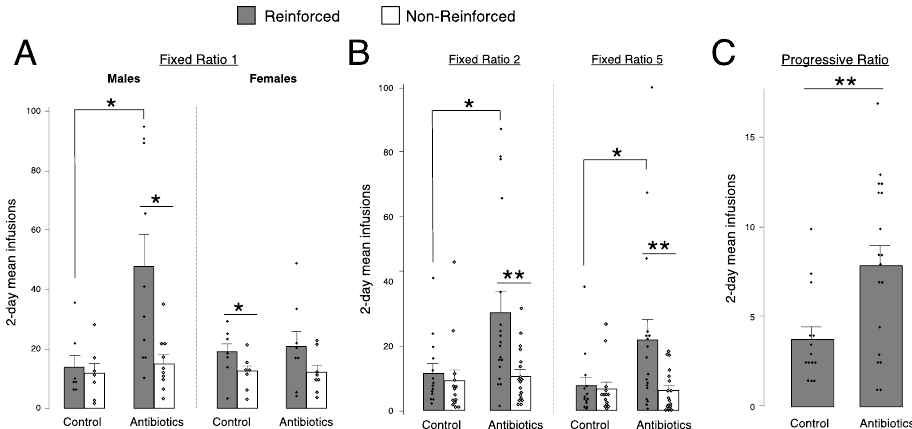
Figure 4. Fentanyl intravenous self-administration in controls and antibiotic-treated animals. All animals self-administered a fentanyl dose of 1.25 µ g/kg/infusion. ( A ) Mean number of infusions across days 4–5 at fixed ratio (FR) 1 in males and females. Infusions were administered via nose pokes and are reported as reinforced (filled bars and circles) and non-reinforced (empty bars and circles) responses. Error bars represent S.E.M., * p < 0.05, n = 7–10/group. ( B ) Mean number of infusions across 2 days at FR2 and 2 days at FR5, collapsed by sex, for reinforced (filled bars and circles) and non-reinforced (empty bars and circles) nose poke responses. Error bars represent S.E.M., ** p < 0.01, * p < 0.05, n = 14–18/group. ( C ) Mean number of infusions across 2 days at progressive ratio, collapsed by sex. Error bars represent S.E.M., ** p < 0.01, n =